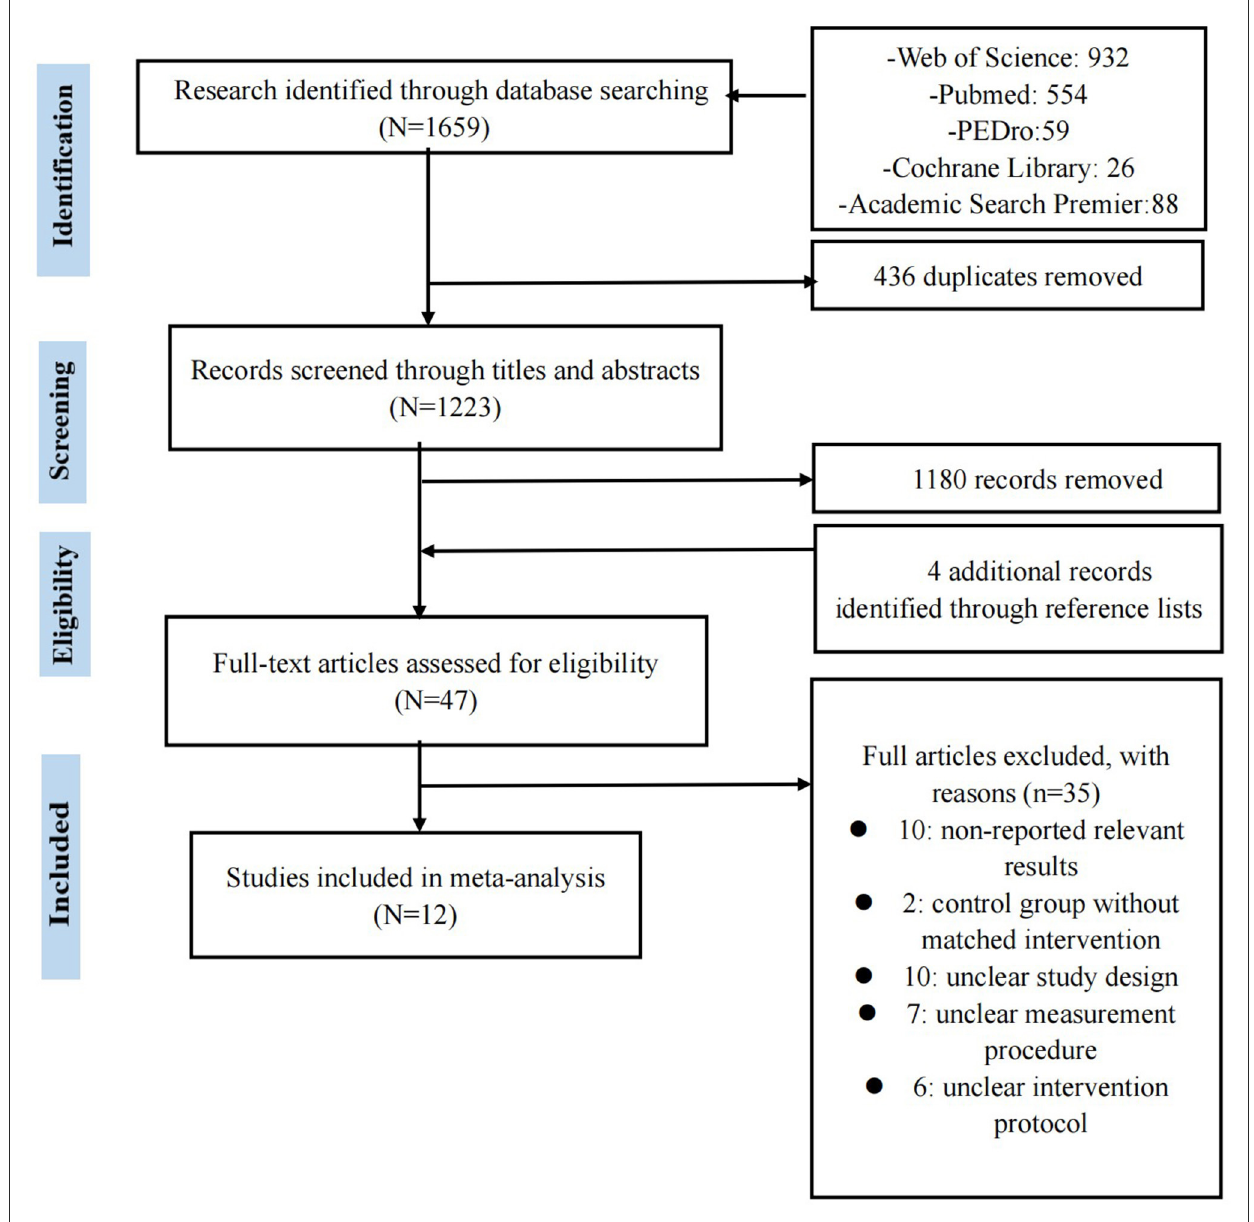
FIGURE1 PRISMA flow diagram showing flow of information through the review.